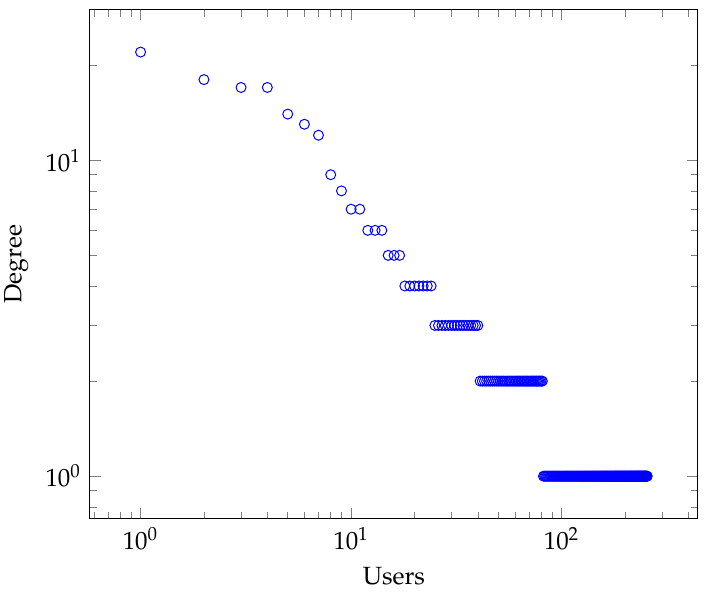
Figure 3. Users’ degree distribution of a generated synthetic